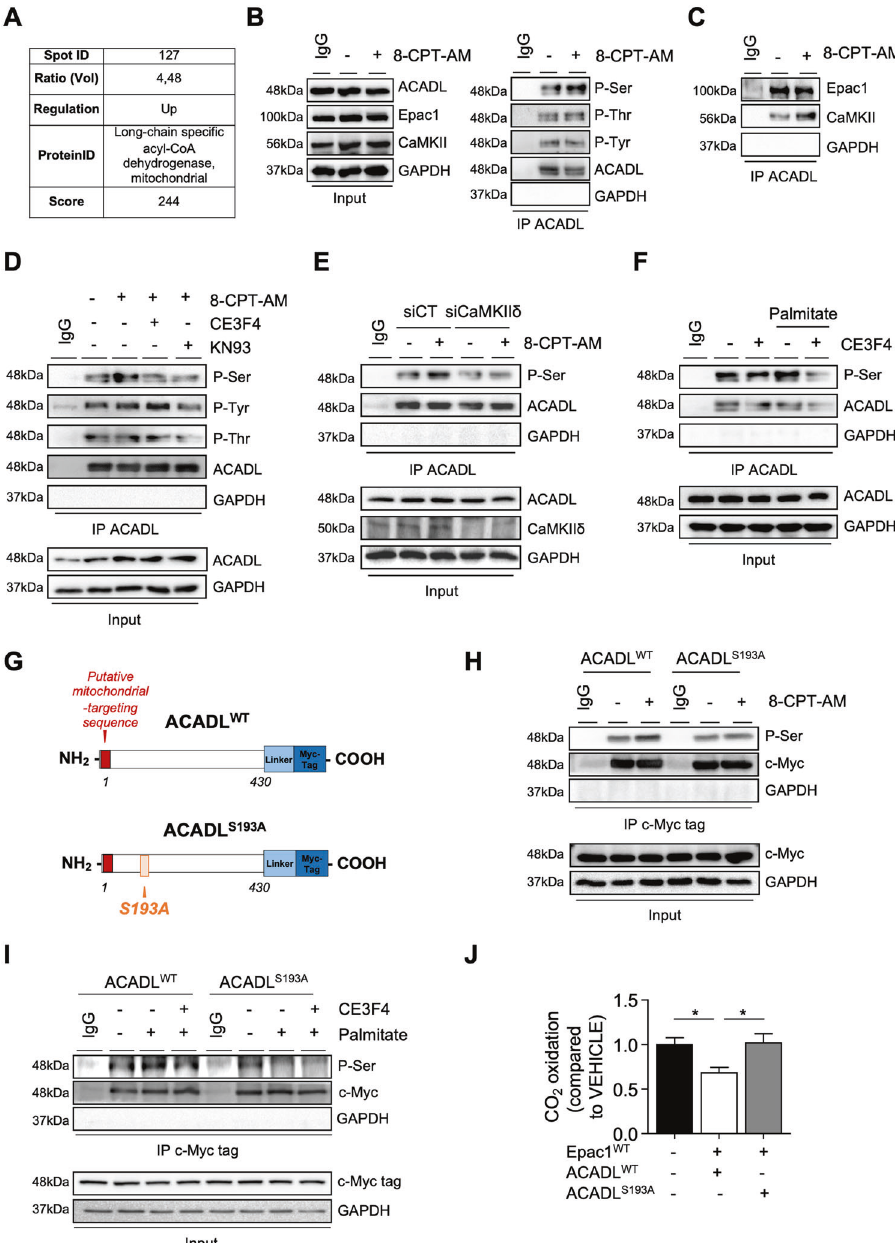
Fig. 5 Epac1-CaMKII targets Acyl-CoA dehydrogenase (ACADL) to decrease FA breakdown. A Phosphoproteome results. The ratio of volume value is indicated in the table. The change in the intensity of the protein spot (127) is indicated as increased (up) in the